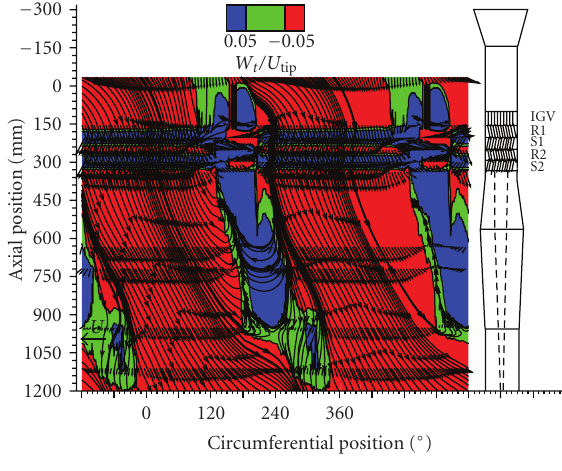
Figure 9: Relative tangential flow component at midspan.